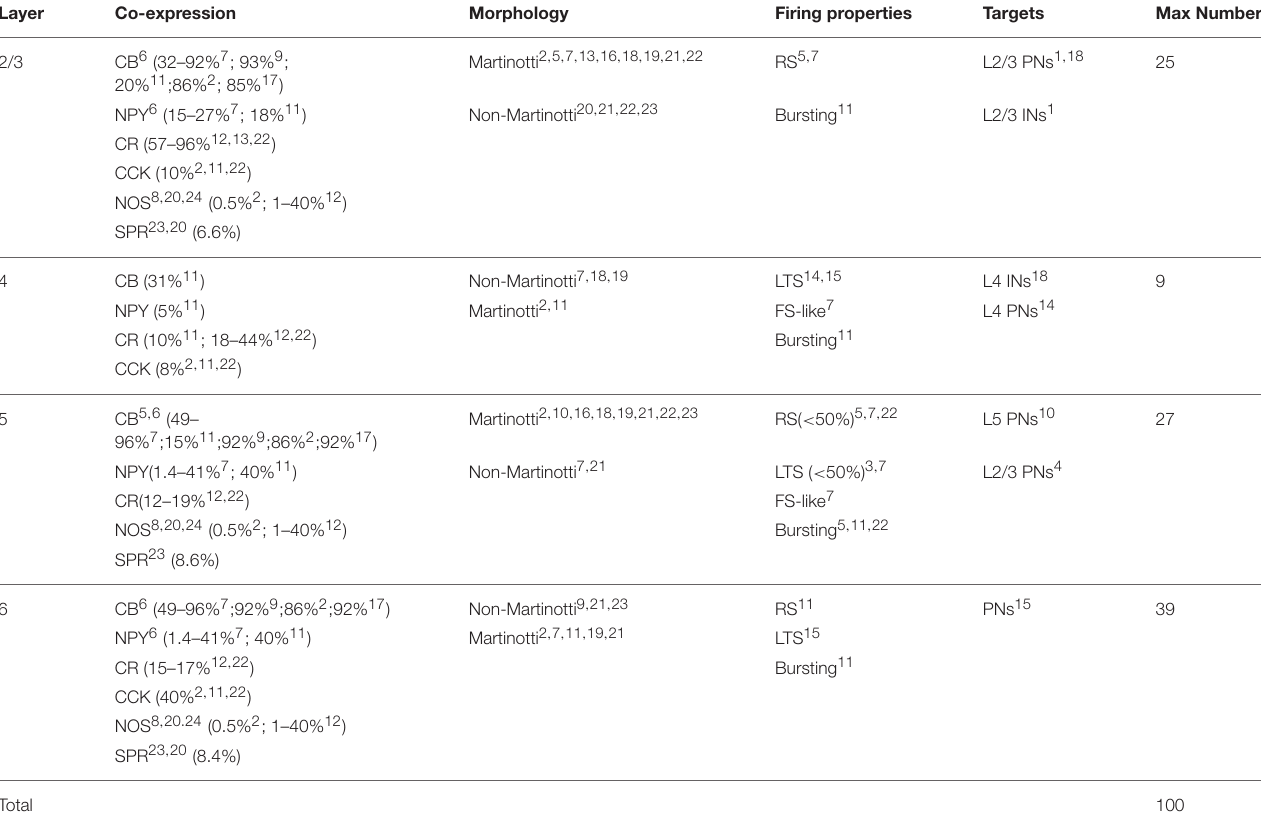
TABLE 2 | Diversity of SOM cells across cortical layers 2–6. Layer Co-expression Morphology Firing properties Targets Max